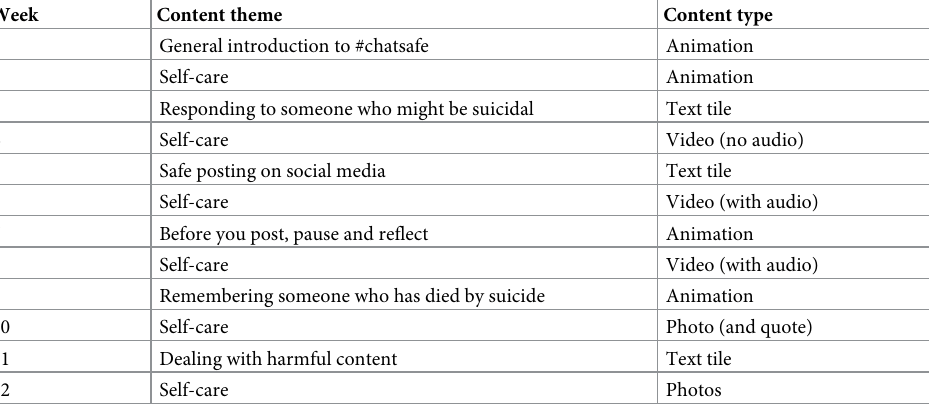
Table 1. Delivery schedule, content theme and content type for each week of the #chatsafe social media campaign.